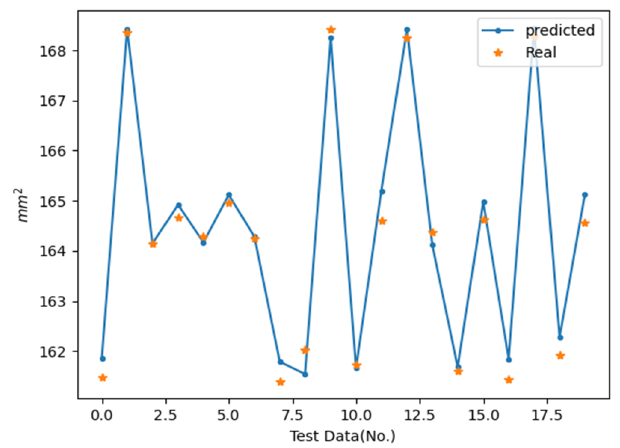
Figure 8. The results of predicted and real data of Linear regression model.